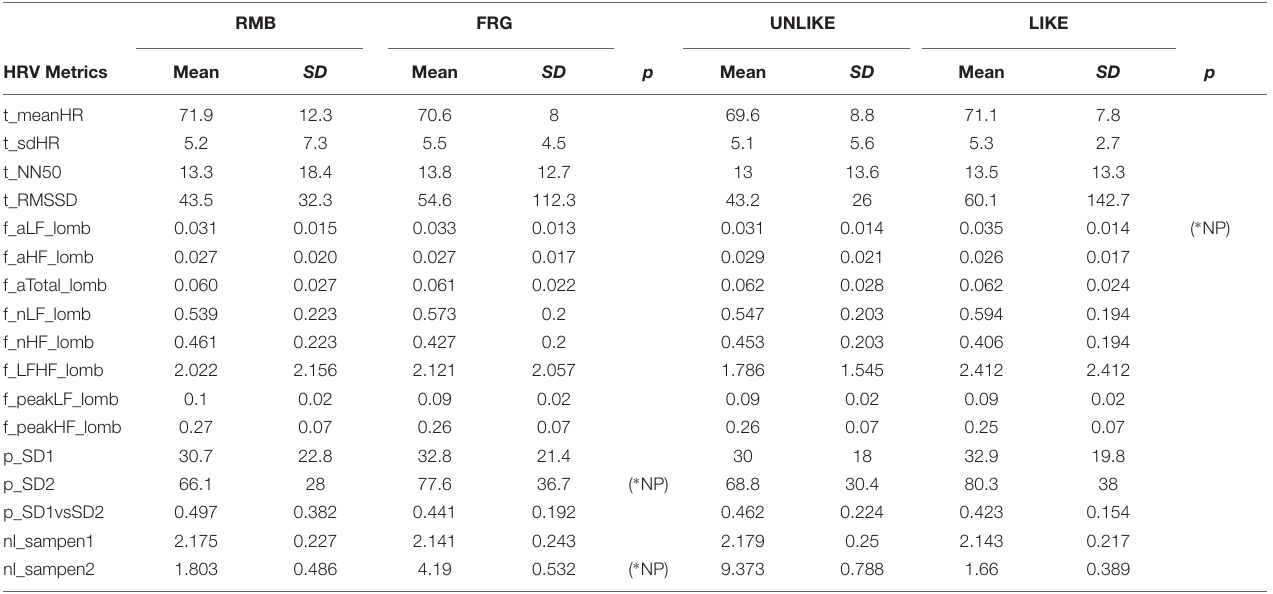
TABLE 2 | Mean comparisons of HRV metrics in the time, frequency and non-linear domains. RMB FRG